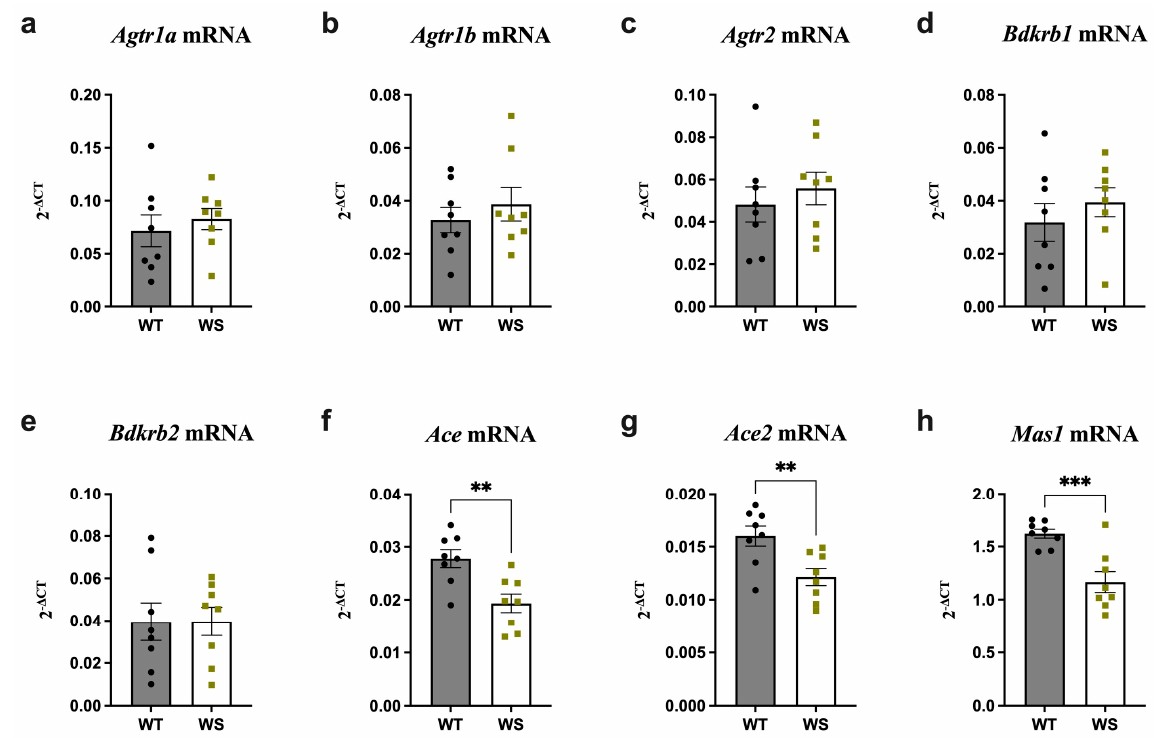
Figure 3. Expression of Ace, Ace2 and Mas1 was substantially downregulated in the hippocampi of treatment-naïve aged Wfs1 -deficient rats. Gene expression was analyzed from the hippocampi of 12.5–13-month-old animals taken directly from their home cages. Relative gene expression levels of ( a ) Agtr1a , ( b ) Agtr1b , ( c ) Agtr2 , ( d ) Bdkrb1 , ( e ) Bdkrb2 , ( f ) Ace , ( g ) Ace2 and ( h ) Mas1 (presented as